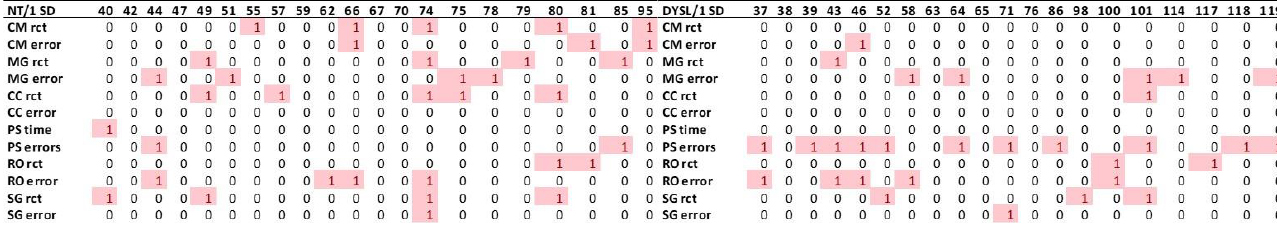
Figure 9. Deviating individual performance/visual/subtest level. NT: neurotypical normal reading children, DYSL: children with dyslexia (numbers in the head row depict the individual subject), rct: reaction time, err: errors, CM: coherent motion, MG: moving gratings, CC: coherent color, PS: pattern sequence, SG: stationary gratings, Ro: rotation.